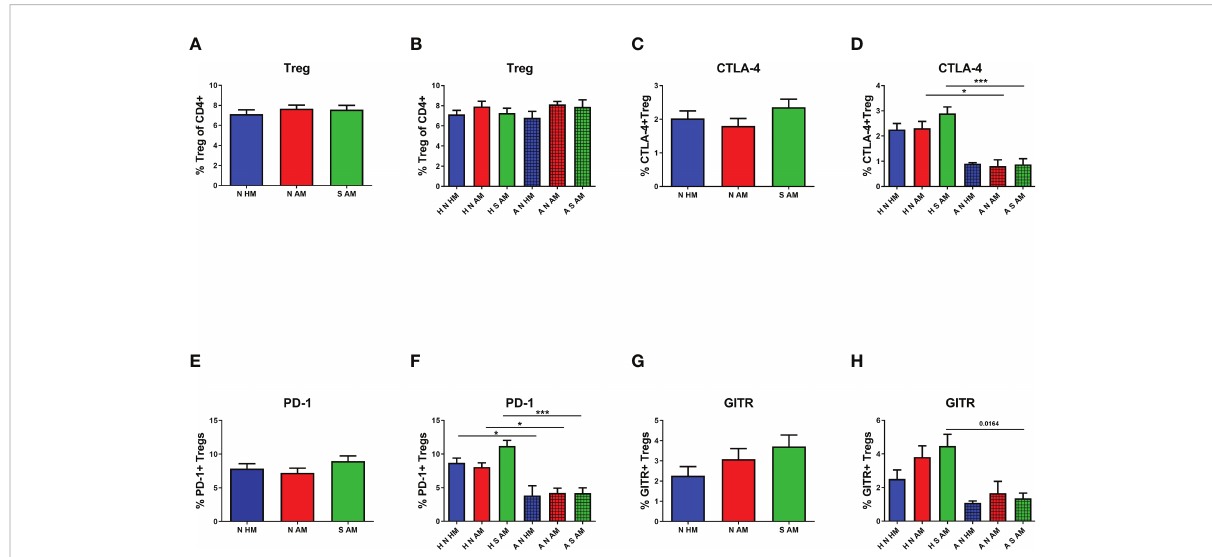
FIGURE 2 The proportion and functional characteristics of Treg in the peripheral blood of 10-year-old children were determined by fl ow cytometry. The percentage of Treg in the peripheral blood in the three basic groups is shown in (A) Percentages of Treg in children divided according to their own as well as maternal allergy status and appropriate probiotic supplementation are presented in (B) The proportion of Treg positive for cytotoxic T-lymphocyte antigen 4 (CTLA-4) in the three basic groups is indicated in (C) CTLA-4-positive Treg in children divided according to their own as well as maternal allergy status and appropriate probiotic supplementation are presented in (D) The presence of programmed death domain 1 (PD-1) on Treg of children divided into the three basic groups (E) and the six subgroups (F) . The cell surface presence of glucocorticoid-induced tumor necrosis factor receptor-related gene (GITR) on Treg in children divided into the three basic groups is indicated in (G) and the six subgroups in (H) N HM, non-supplemented children of healthy mothers; N AM, non-supplemented children of allergic mothers; S AM, E coli O83:K24:H31-supplemented children of allergic mothers; H N HM, healthy non-supplemented children of healthy mothers; H N AM, healthy non-supplemented children of allergic mothers; H S AM, healthy E coli O83:K24:H31-supplemented children of allergic mothers; A N HM, allergic non-supplemented children of healthy mothers; A N AM, allergic non-supplemented children of allergic mothers; A S AM, allergic E coli O83:K24:H31-supplemented children of allergic mothers; Treg, regulatory T cells; *p ≤ 0.0125 (adjusted p value); ***p ≤ 0.00025 (adjusted p